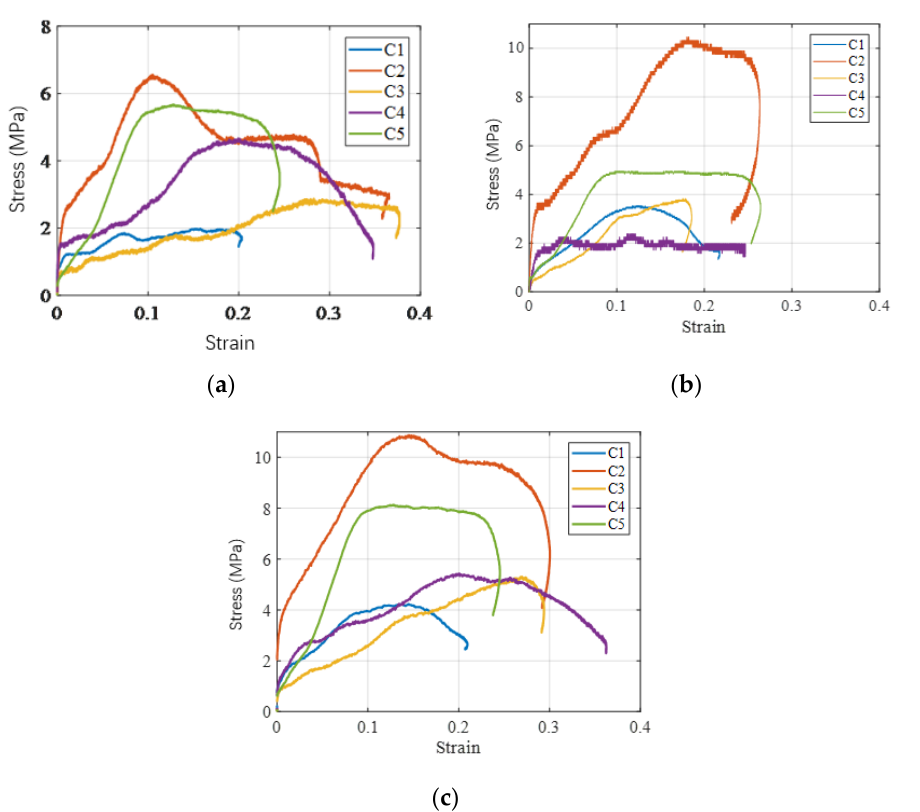
Figure 6. Stress–strain curves of the specimens under different working conditions. ( a ) v0 = 14 m/s, ( b ) v0 = 18 m/s, ( c ) v0 = 22 m/s.